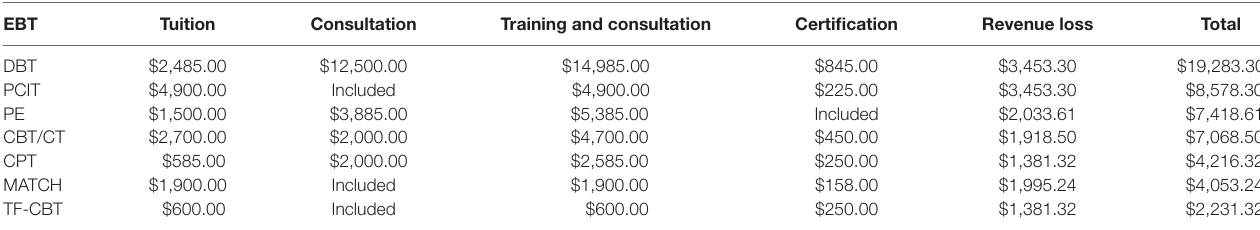
TaBle 2 | Training and consultation costs per